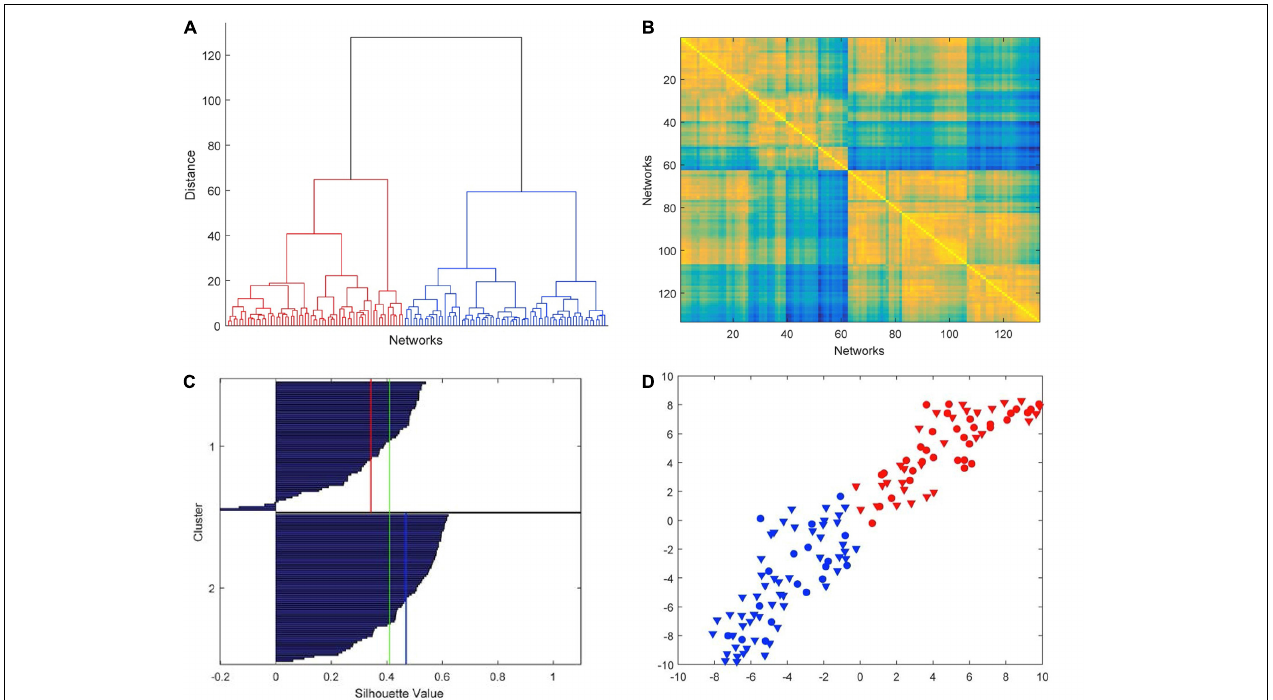
FIGURE 4 | Results of the hierarchical cluster analysis based on five-node GCD. (A) The dendrogram obtained with Ward’s distance: the adopted two-cluster partition is evidenced by red/blue color. (B) Heatmap of the GCD matrix: “hot” colors represent short distances (high similarity) and vice versa “cold” colors. The order of rows/columns is consistent with the ordering of the leaves in the dendrogram. (C) Silhouette diagram: The red/blue lines mark the mean silhouette values of the respective clusters, and the green line the overall mean value. (D) t-SNE (stochastic neighbor embedding): In this 2D plot, the clusters are contiguous but well